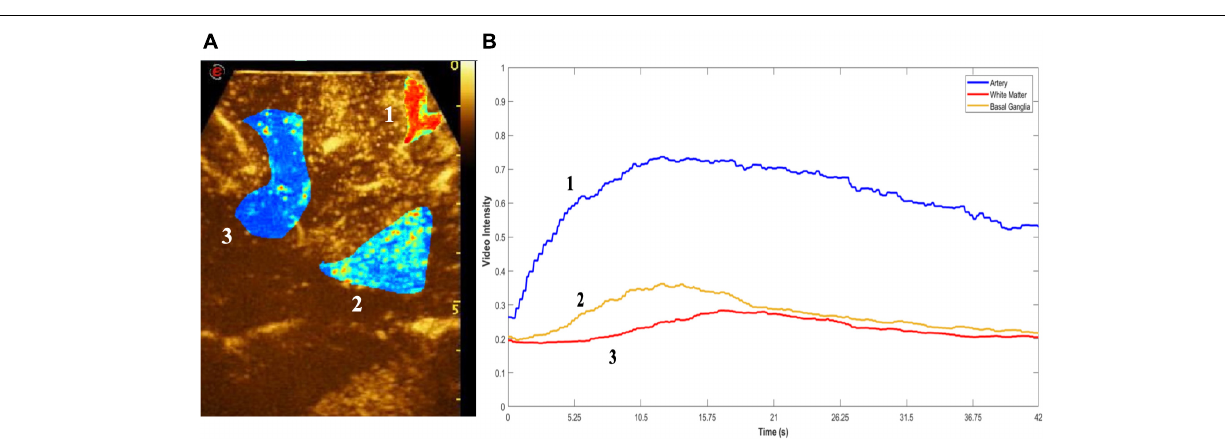
FIGURE 2 | Quantitative CEUS. Quantitative analysis of MBs distribution. (A) Region of interest (ROI) is drawn on key structures (1, artery-blue; 2, white matter-red; 3, basal ganglia-yellow), following which peak enhancement and time-intensity curves (TICs) were quantified (B) . This enables discernment between different types of brain tumors as well as regions and structures within the